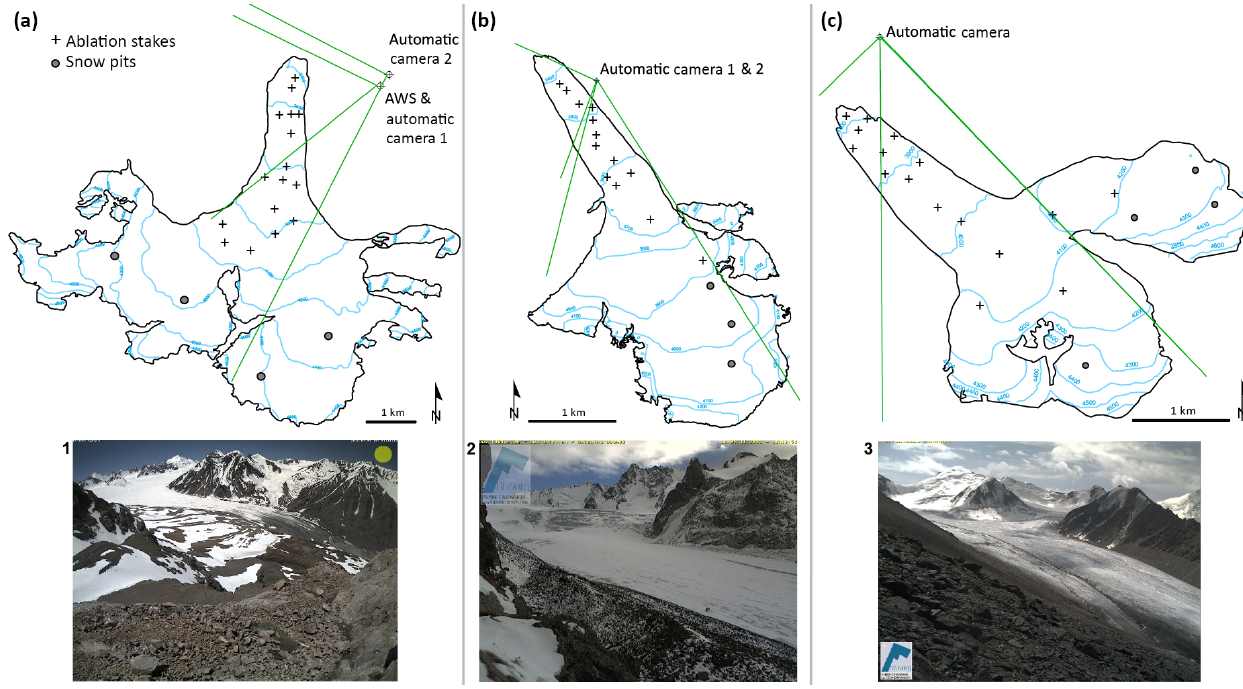
Figure 2. Glacier monitoring network at (a) Abramov, (b) Golubin and (c) Glacier no. 354. A photograph taken by the terrestrial cameras is shown for (1) Abramov, (2) Golubin and (3) Glacier no.